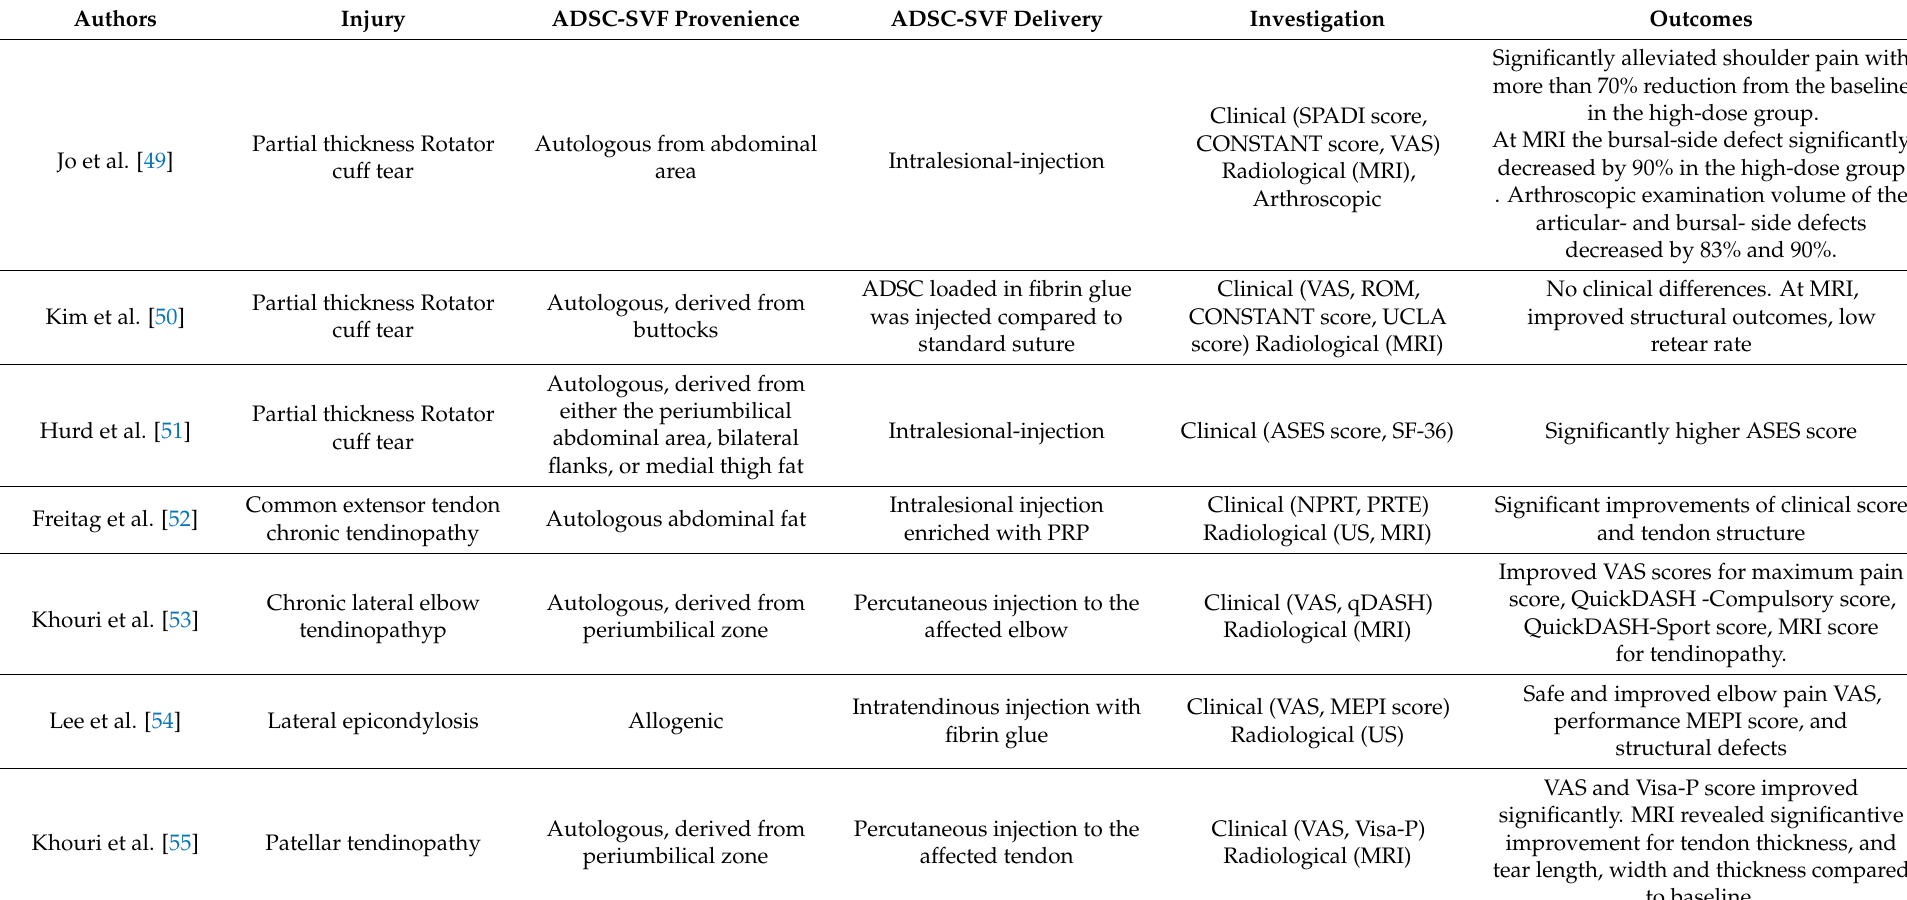
Table 2. Enzymatically derived ADSC-SVF human tendinopathy and tendon